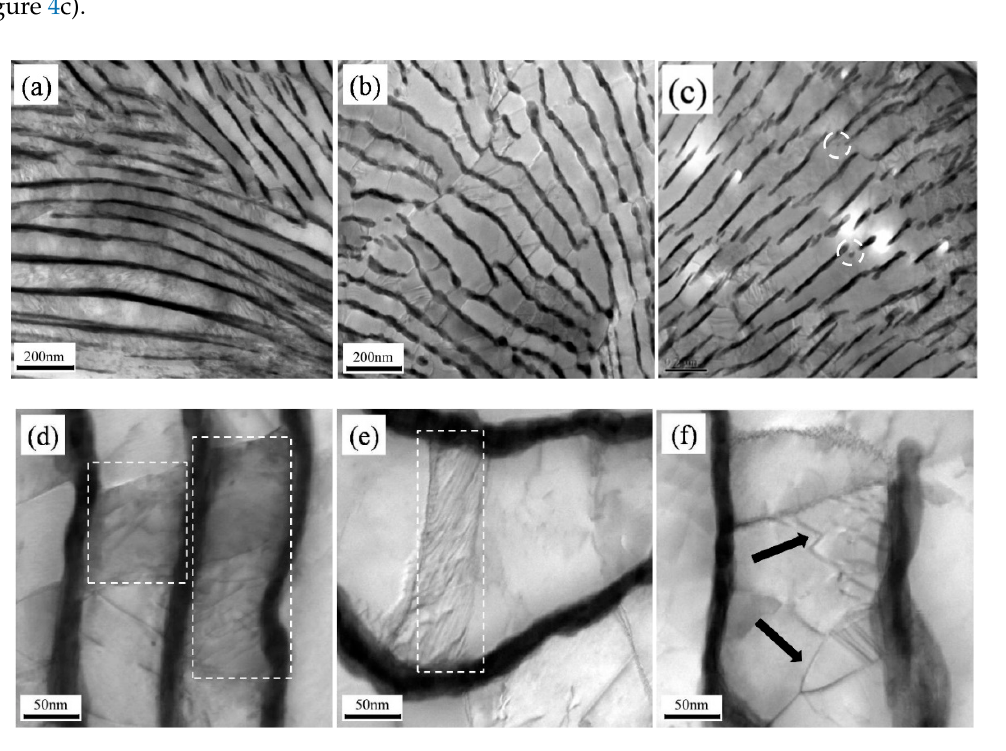
Figure 3. Microhardness of steel wires after annealing at 450 °C for different time: ( a ) mean microhardness at different measuring points of wires annealed for 0, 5, and 60min; ( b ) mean microhardness and microhardness difference of wires annealed for the entire time range.